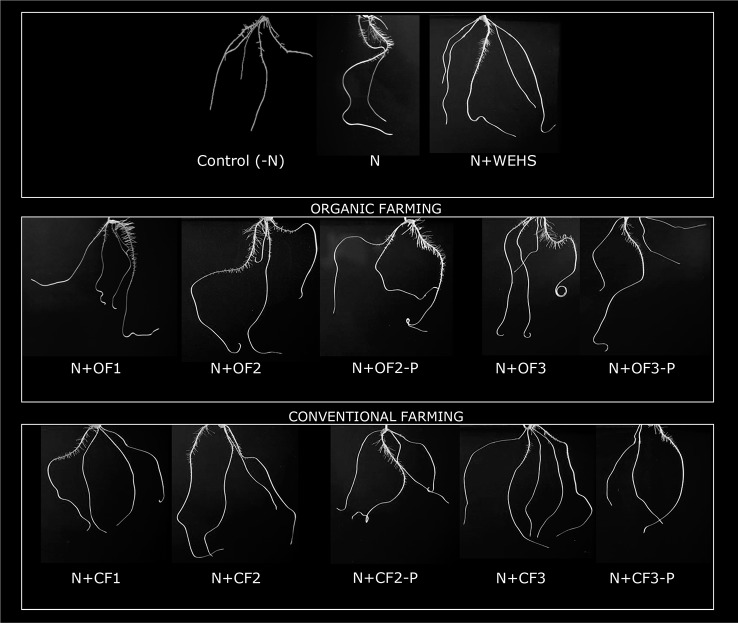
Representative pictures of whole root system of maize plants (5 days old) after 24 h of treatment (in nutrient solution): N-free nutrient solution [Control (-N)], nutrient solution containing nitrate (0.5 mM Ca(NO3)2) with or without 5 mg Corg L−1 water-extractable humic substances (WEHS) (humic substances isolated from sphagnum peat; N+WEHS or N, respectively), nitrate (0.5 mM Ca(NO3)2) with dissolved humic substances (DHS) (5 mg Corg L−1) isolated from organic farming (OF) soils (N+OF1, N+OF2, N+OF-P2, N+OF3, and N+OF-P3) or isolated from conventional farming (CF) soils (N+CF1, N+CF2, N+CF-P2, N+CF3, and N+CF-P3). The code name of samples is reported in Figure 1.